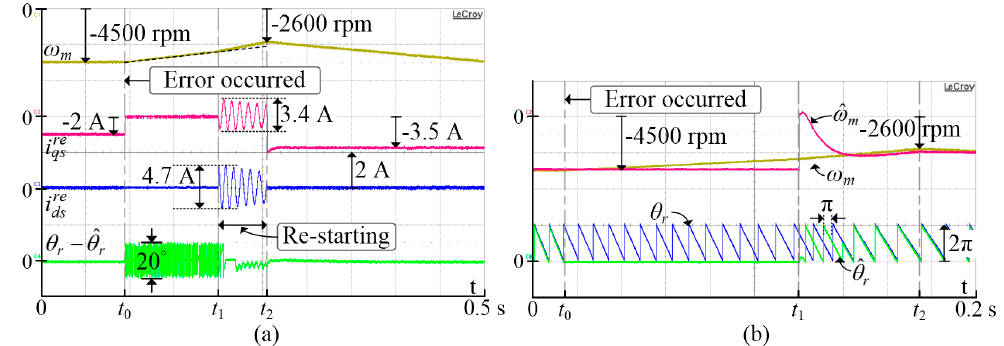
Figure 19. ( a ) Restarting the motor directly from θ r = 270° with a negative speed under the rated load; ( b ) Amplified waveforms.